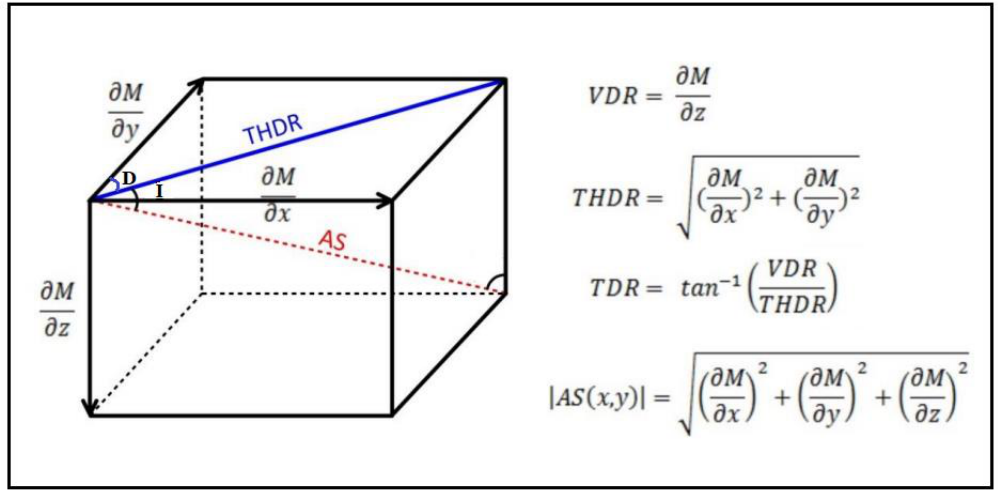
Figure 4. Definition of the geometrical relationships between VDR, THDR, TDR, and AS. D and I represent the angles of declination and inclination, respectively [17].